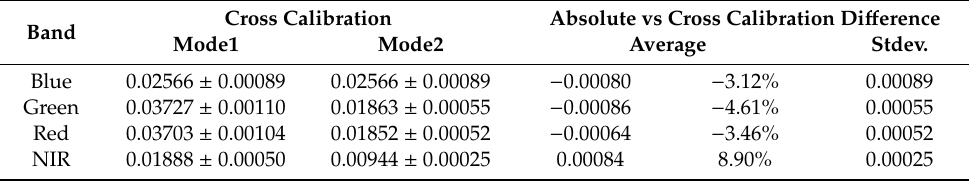
Table 8. The cross calibration vs. absolute coe ffi cients.